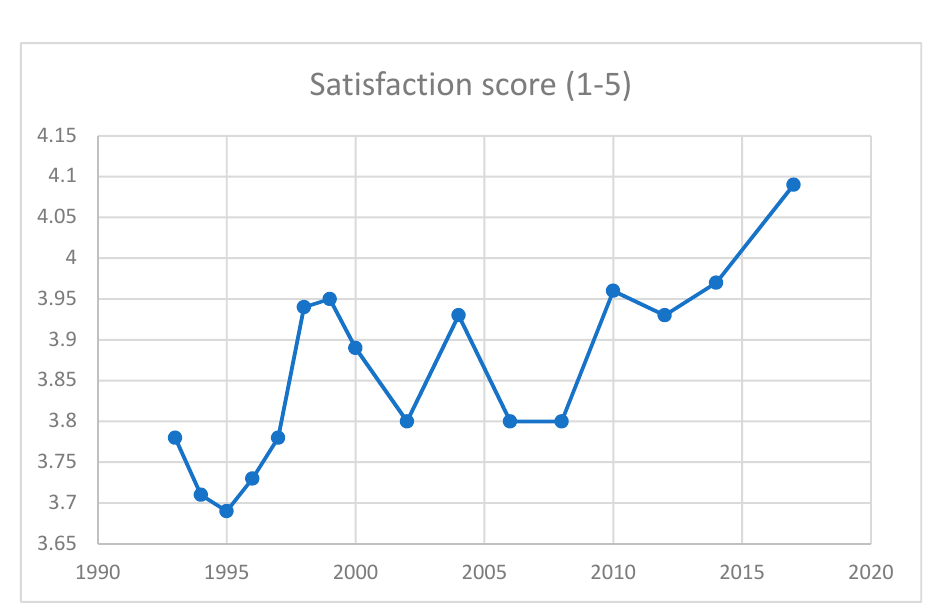
Figure 6. Satisfaction score (Source: Bain & Company’s surveys 1993-2017).